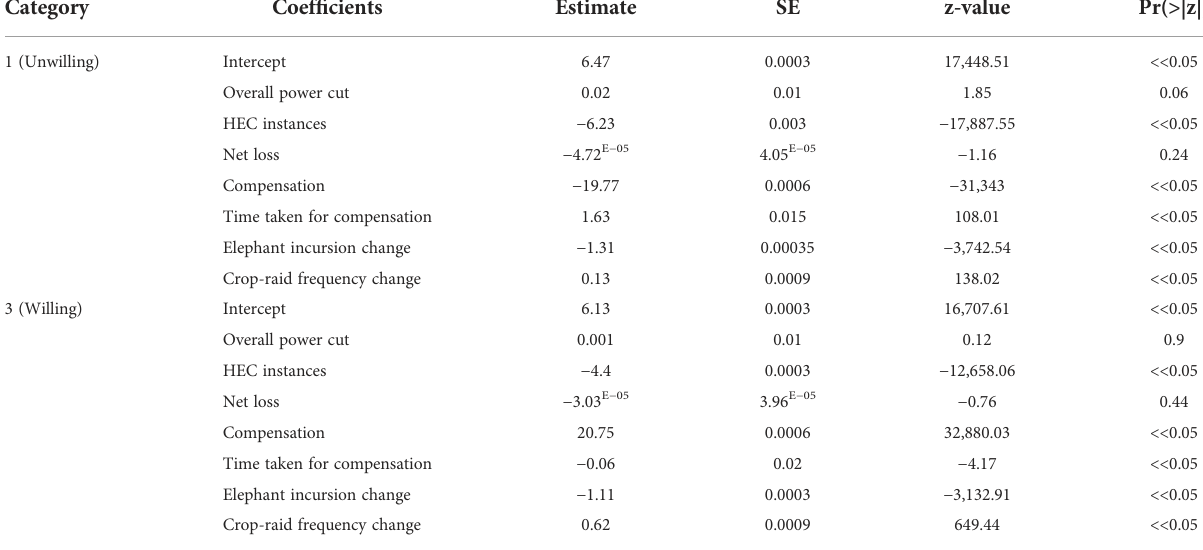
TABLE 5 Table representing estimates and level of signi fi cance of best fi t multinomial logistic regression for describing the relationship with predictor variables and categorical variable of willingness to pay ( “ 2 ” = true zero, as the reference category) on the barrier sites. Category